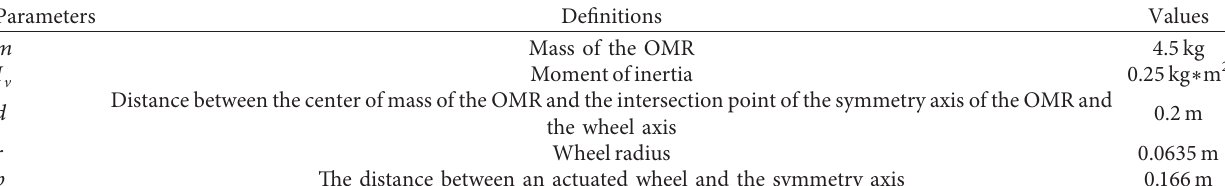
Table 1: Model parameters of the OMR.